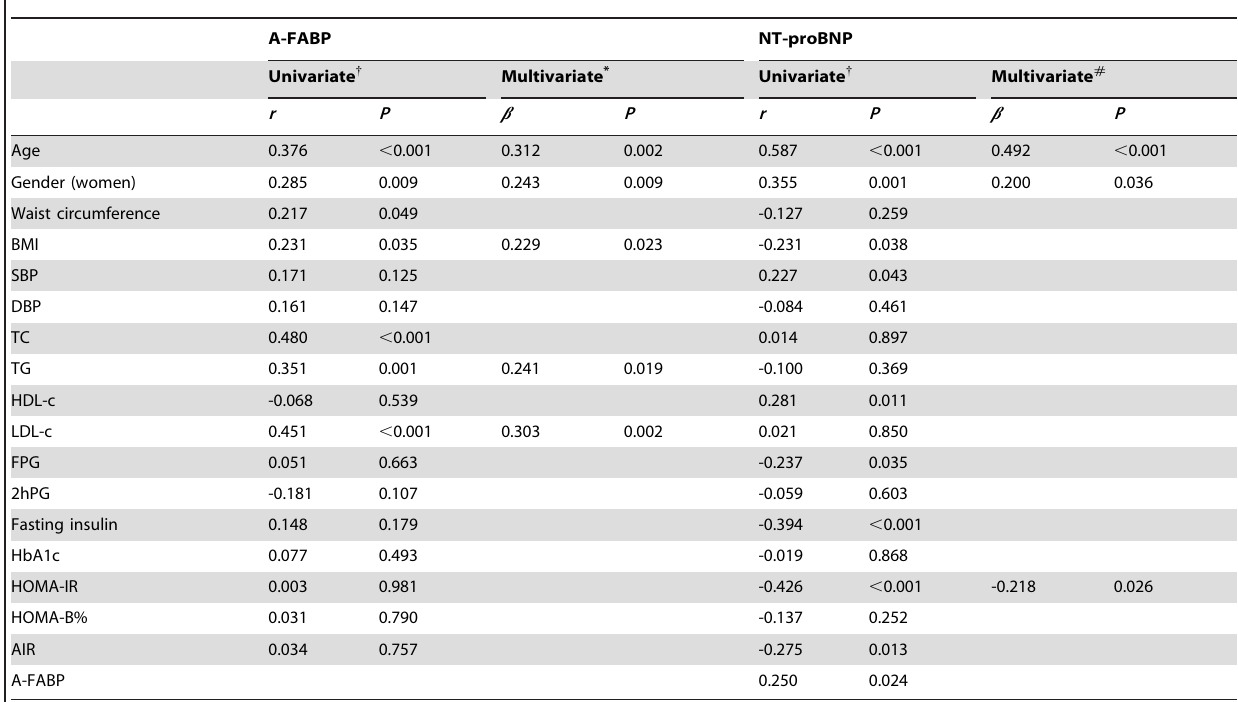
Table 3. Anthropometric and biochemical parameters showing significant correlations with serum A-FABP and NT-proBNP after the 48-week rosiglitazone